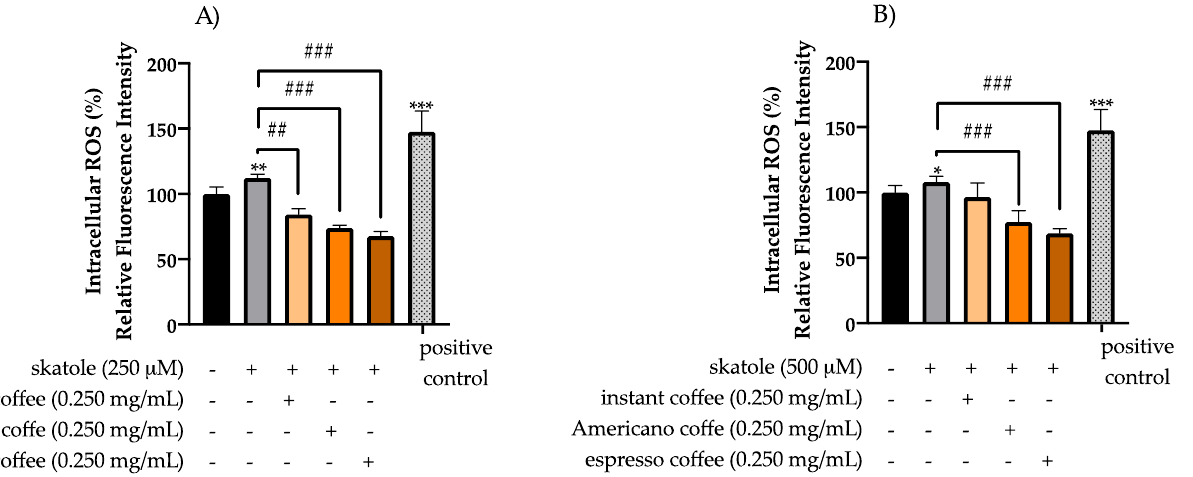
Figure 3. Evaluation of intracellular ROS levels under challenging conditions in HT-29 cells. The effect of treatment with different types of coffee extract (instant, Americano, and espresso) at 0.250 mg/mL after skatole treatment of 250 µM ( A ) and 500 µM ( B ) on the production of intracellular ROS levels was determined by H 2 DCF-DA assay after 24 h of treatment, and compared to the mock control. Cells treated only with H 2 O 2 were used as a positive control. The graphs represent the mean and SD of three separate experiments. * p -value ≤ 0.05, ** p -value ≤ 0.01 and *** p -value ≤ 0.001 compared to untreated control (calculated as fold-change relative to control cells, arbitrarily set at 100%). ## p -value ≤ 0.01 and ### p -value ≤ 0.001 skatole versus coffee